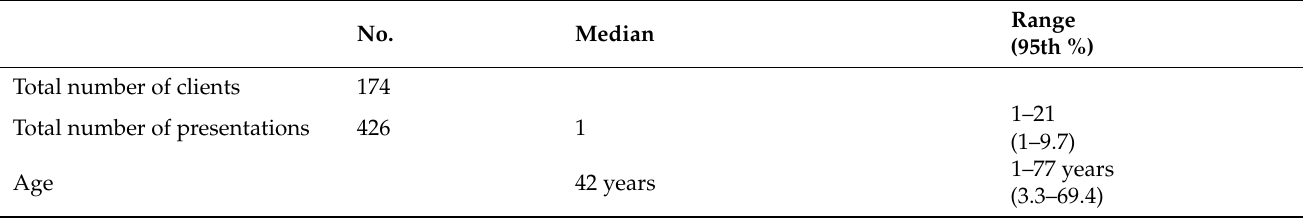
Table 1. Summary of client presentations to Mission Health Nurse-led